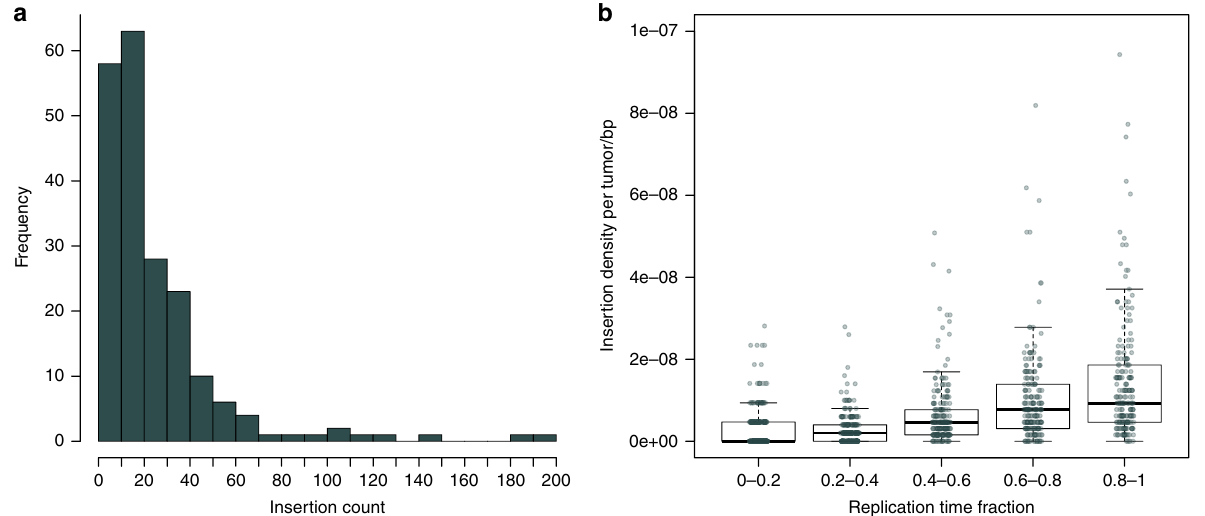
Fig. 1 Distribution of somatic insertions across 202 colorectal tumors and over replication time. a Frequency of somatic insertion counts in 202 colorectal tumors. b Insertion density over replication time. The genome was strati fi ed by replication time in fi ve categories where 0 referred to the earliest replication timing. Each point represents insertion density in the corresponding category for each of the 202 tumors. Boxplot shows median, interquartile range (IQR), and whiskers extend to the most extreme data points which are no more than 1.5 times the